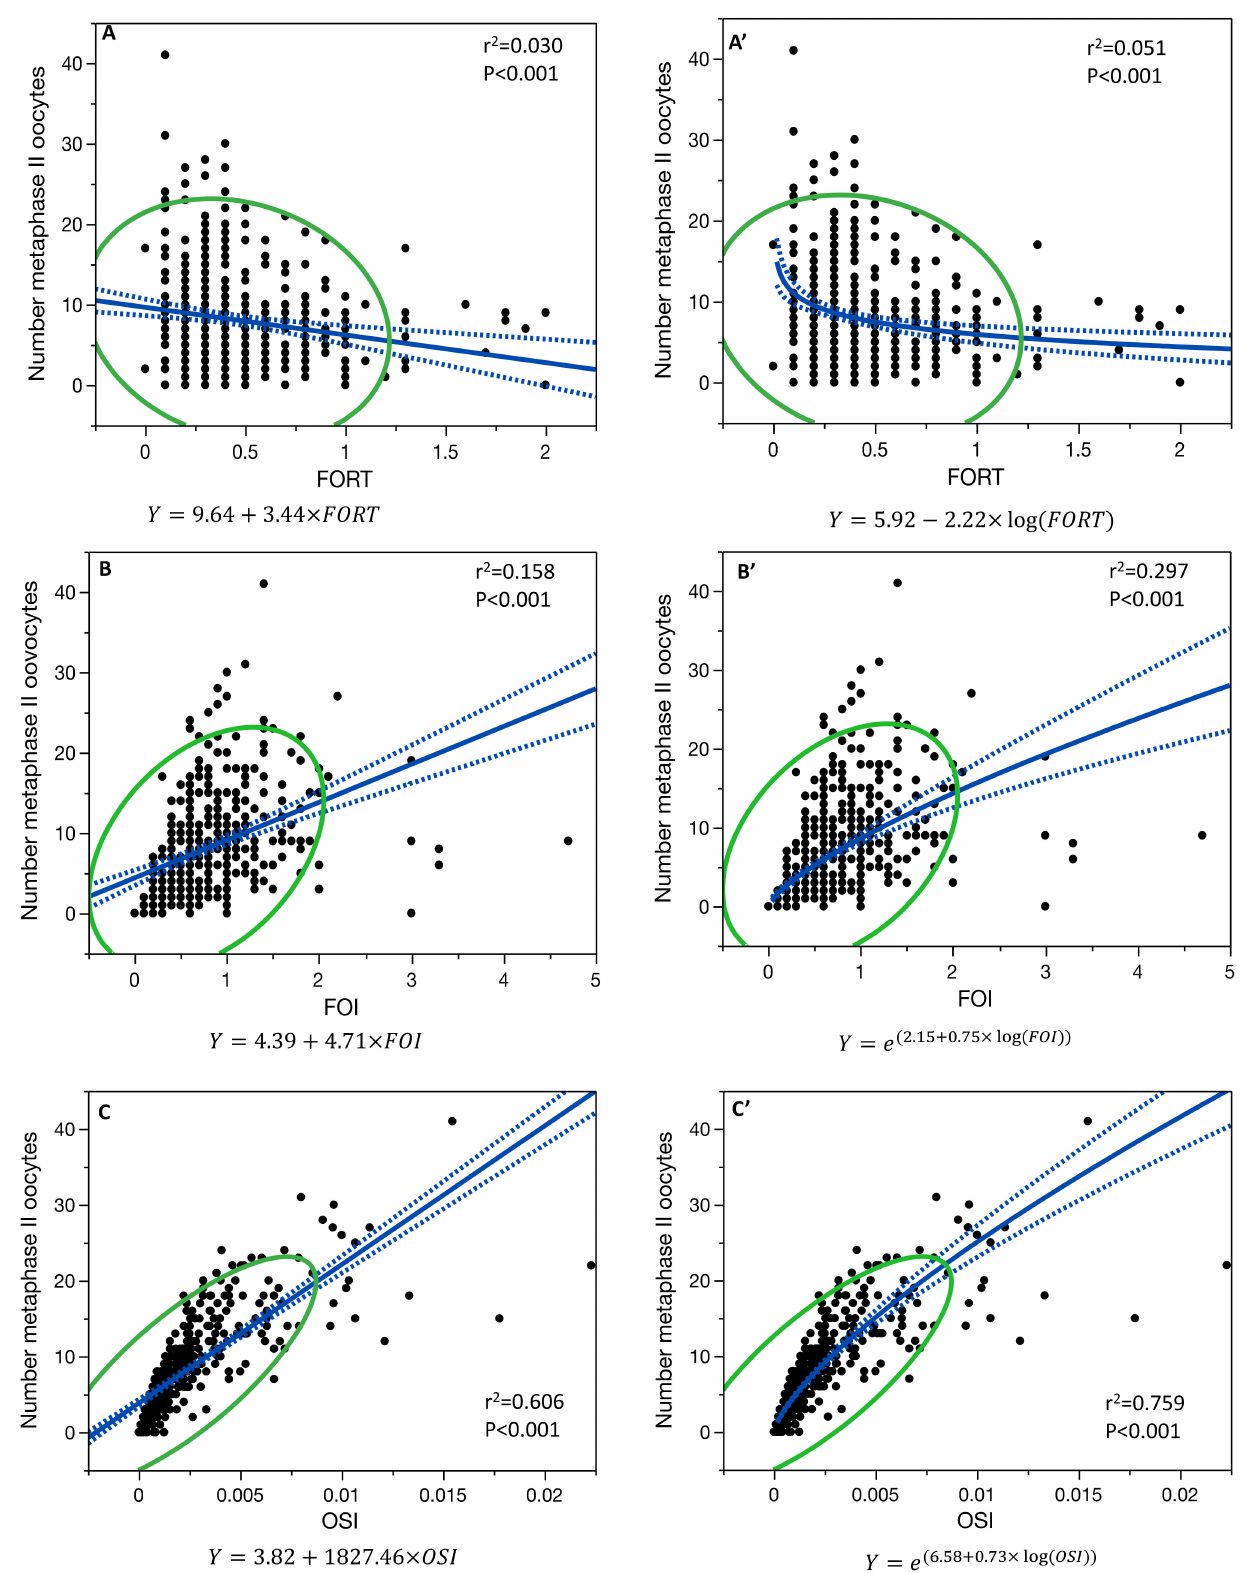
Figure 3. Single-variable linear regression model for the relationship between the number of metaphase II oocytes collected and FORT ( A ), FOI ( B ), and OSI ( C ), and the single-variable non-linear regression model for FORT ( A’ ), FOI ( B’ ), and OSI ( C’ ). Blue line is the fit line of the model with its confidence interval; green line is the 95% density